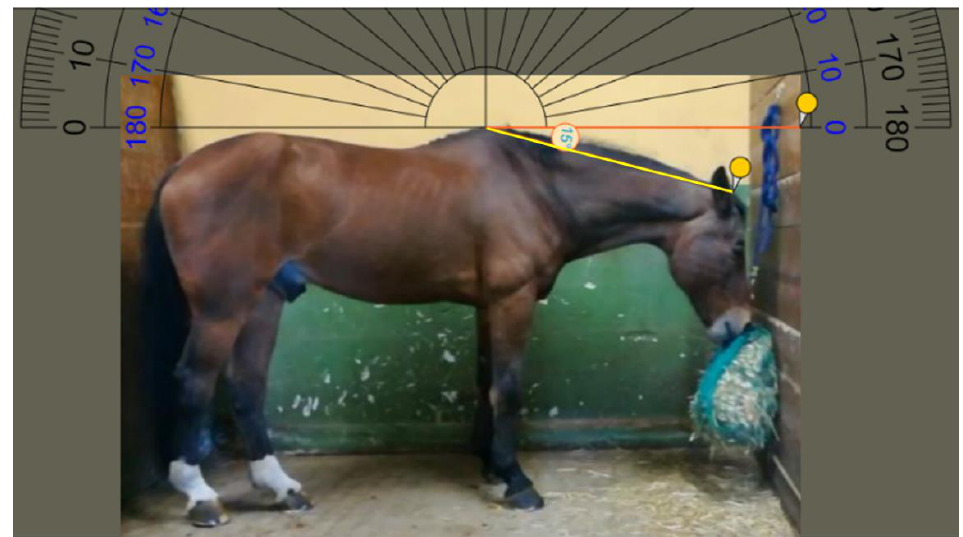
Figure 4. Low hay net position (LP): angle formed between the yellow line running from the withers to the poll of the neck and the reference line crossing the withers and parallel to the ground. Frames of horses eating in HP were selected as shown in Figure 5: the position of the green line (from the withers to the poll of the neck) formed an angle of 15 ± 3 ◦ with the reference line crossing the withers and parallel to the ground.